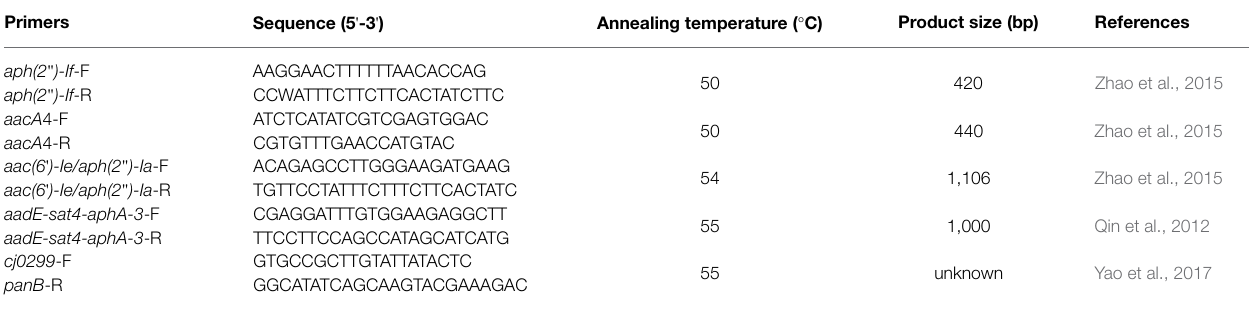
TABLE 1 | PCR primers used in this study.